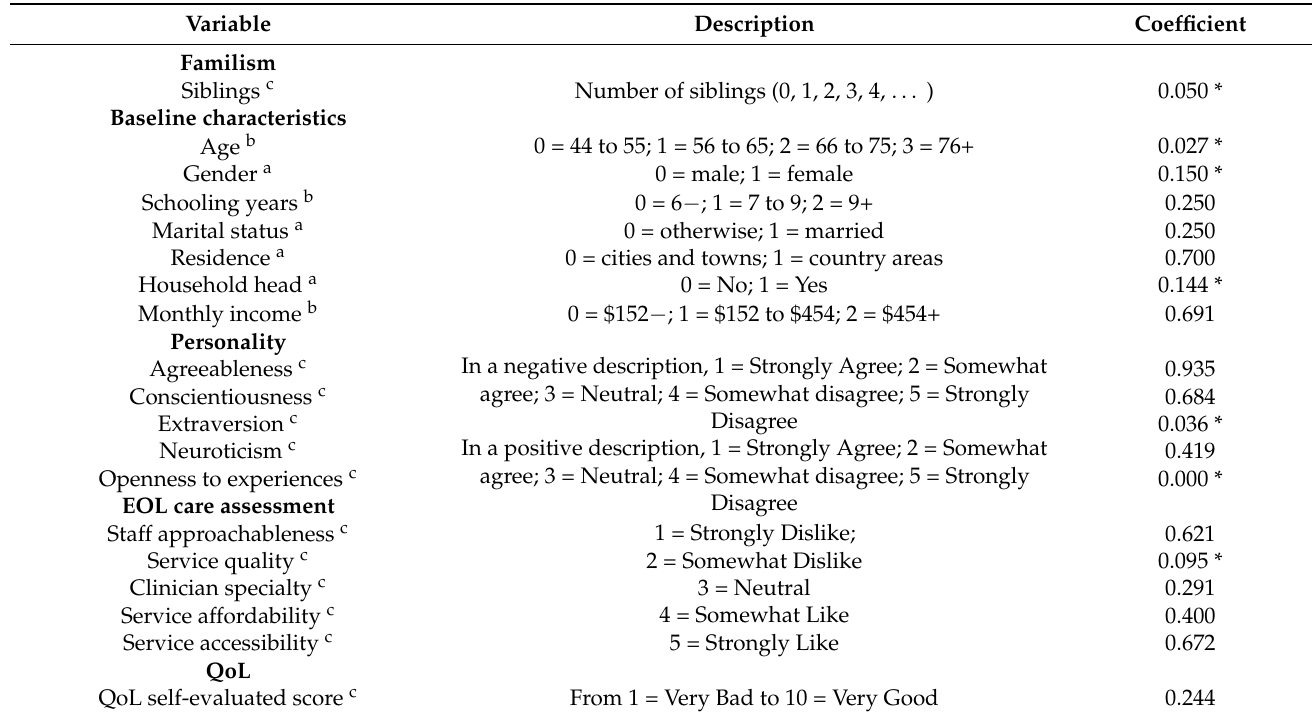
Table A2. Univariate analysis results.